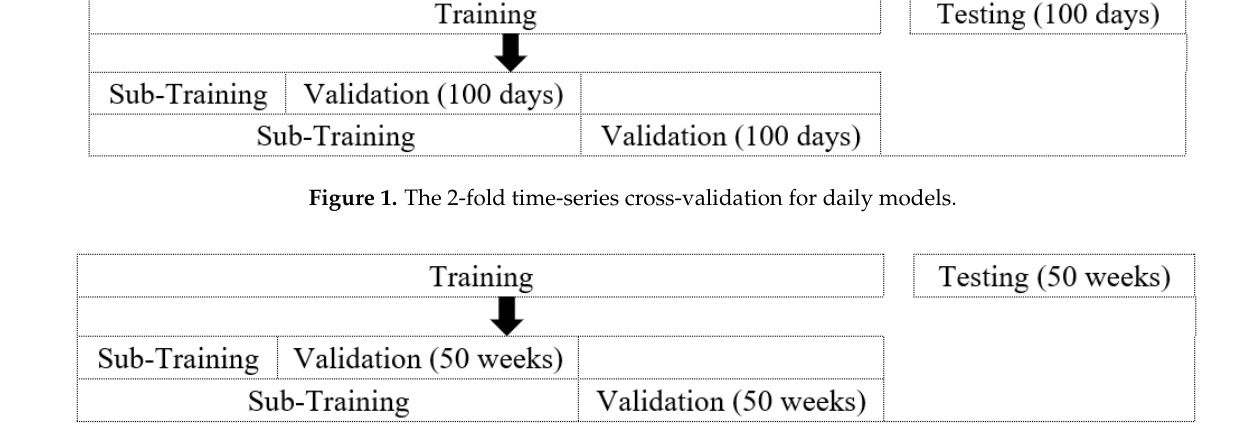
Figure 2. The 2-fold time-series cross-validation for weekly models. Table 5. Validation results from daily models. Numbers are truncated to four decimal places or two decimal places in percent form.